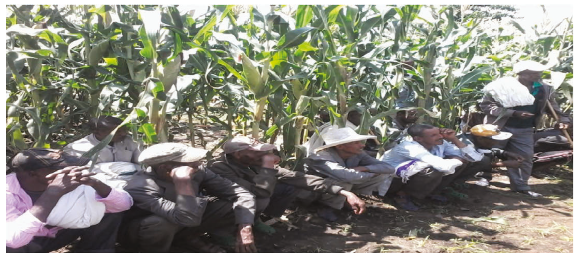
Figure 3: Participant farmers at field day. Table 6: A pair-wise ranking matrix of attributes for the selection of open pollinated (OPV) maize varieties in